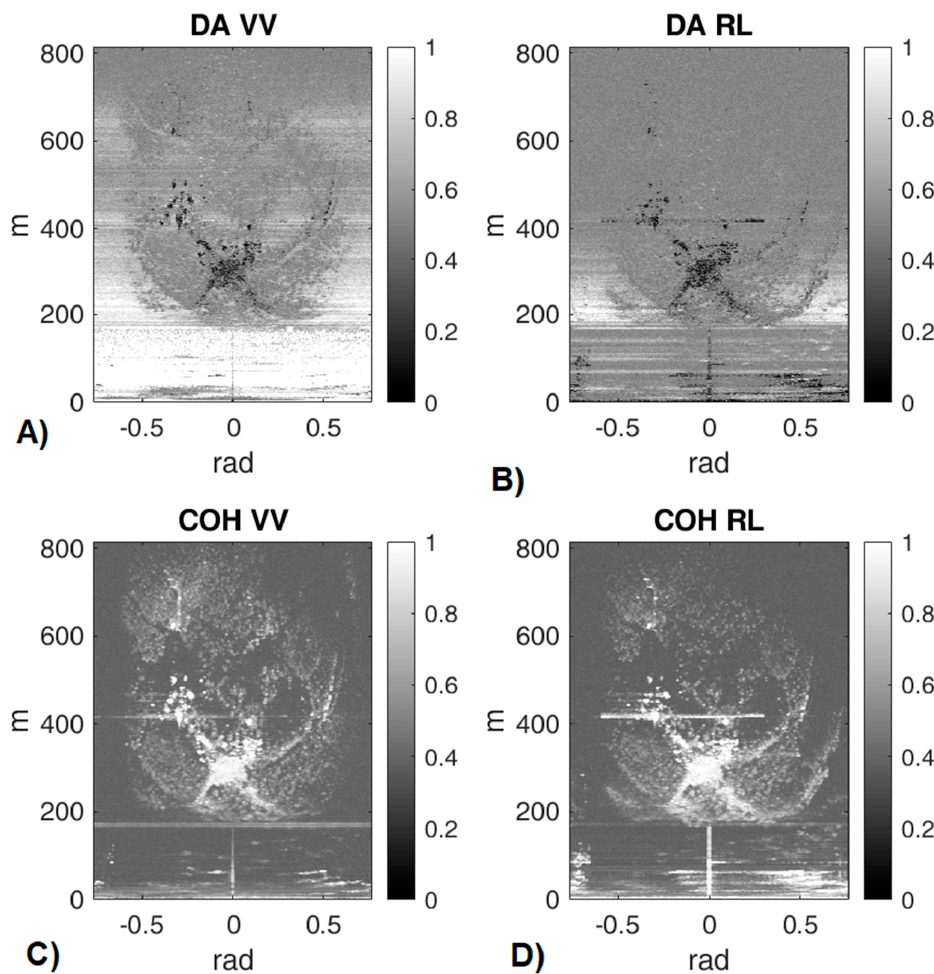
Figure 21. DA and COH maps calculated for the VV and RL configuration, for the long temporal interval. ( A ) DA VV; ( B ) DA RL; ( C ) COH VV; ( D ) COH RL. Remote Sens. 2019 , 11 , x FOR PEER REVIEW